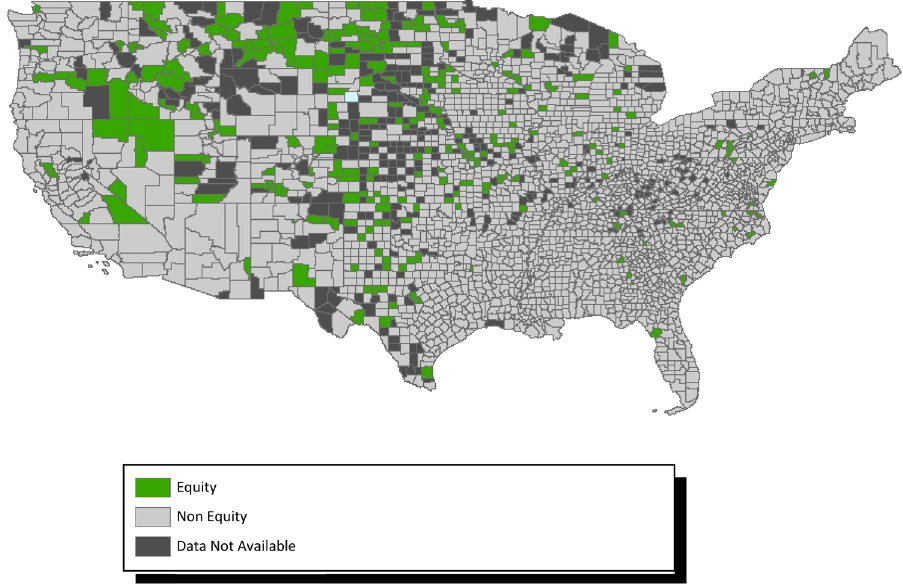
Figure 3. County level racial equity in optimal births—white to black. Map generated in ArcMap 10.7 (https:// www. esri.